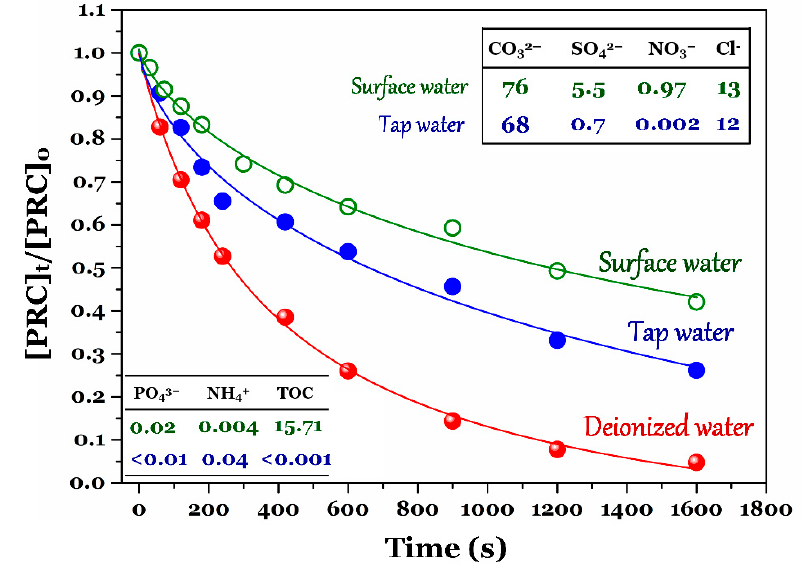
Figure 7. Comparison of PRC degradation efficiency under different kinds of water samples (experimental conditions: [PRC] o ≈ 10 µ M, [NaClO] o = 100 µ M, pH = 7.0, and UV photon flux = 3.14 × 10 − 6 photon fluxes). Table 3. Regression coefficients values (coded variables) of the polynomial model of responses for removal efficiency of PRC after 10 min.